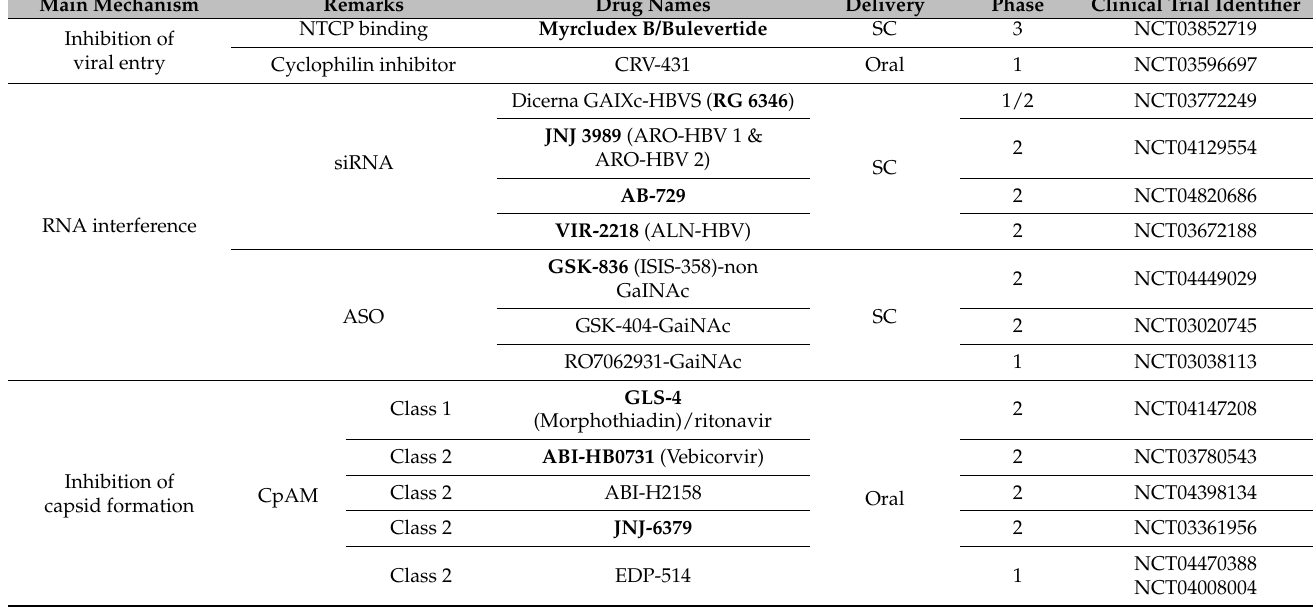
Table 2. Novel antiviral agents in clinical phases of development.